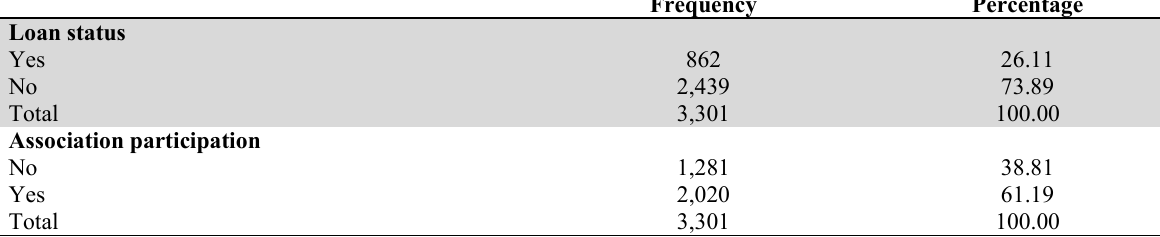
100.00 Source: The authors’ calculation